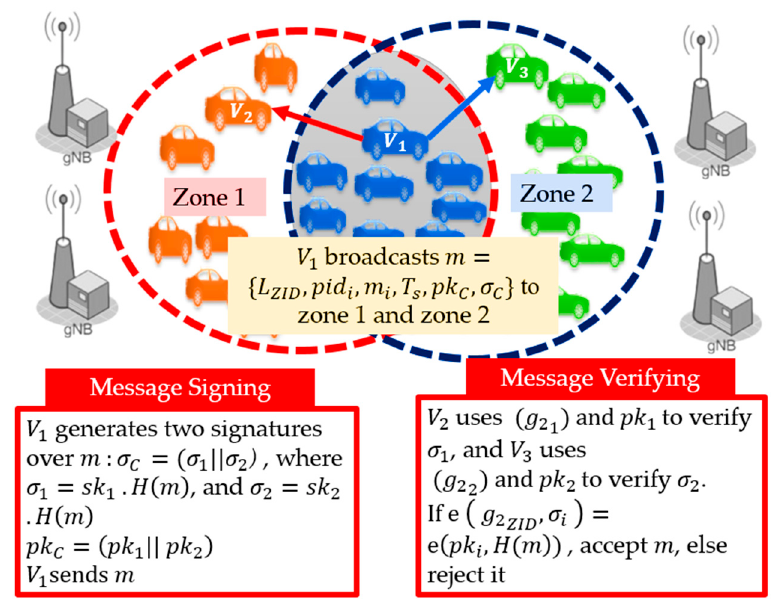
Figure 8. Multi-zone authentication using the signature concatenation (SCA) method.